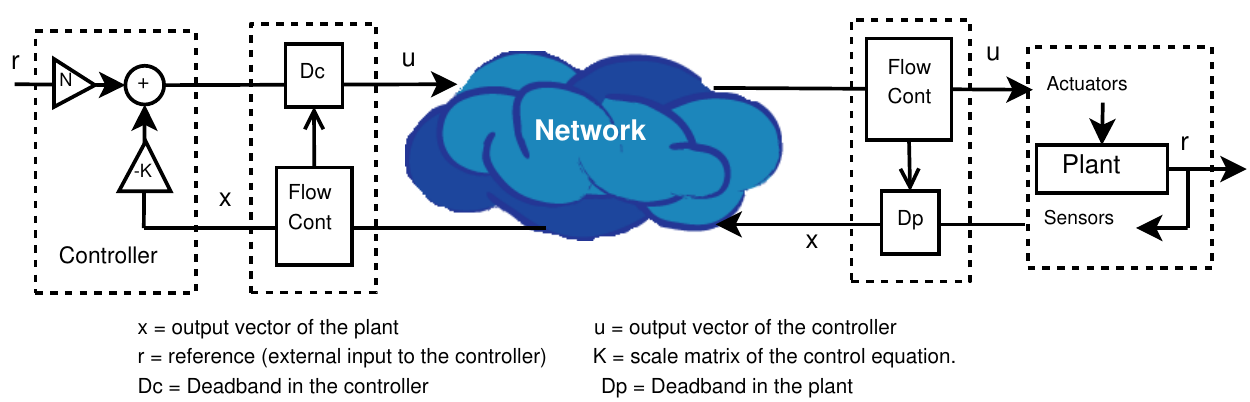
Figure 1. NAD basic scheme.